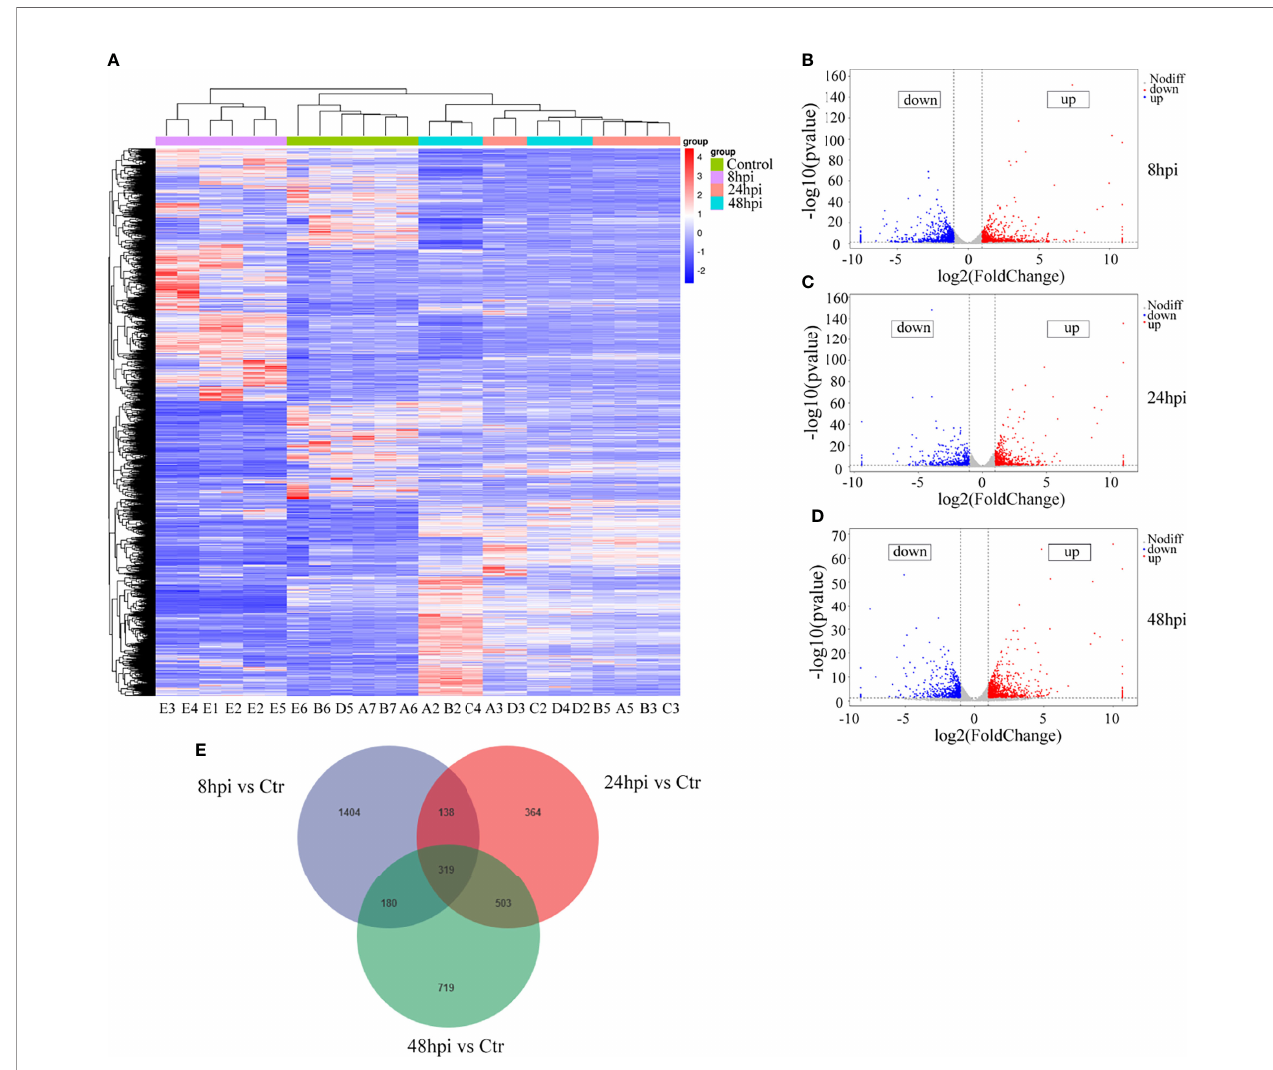
FIGURE 4 | RNA-seq sequencing analysis of H1N1-infected hNEC cells. After 8h, 24h, and 48h of H1N1 virus infection of hNEC cells, the cells were collected for transcriptome sequencing (RNA-seq). (A) Heat map showing all differential gene expression pro fi les of H1N1 virus-infected hNEC cells at 8h, 24h, and 48h compared to control. Each column represents a hNEPCs sample from a different person. (B) Volcano plot showing all up- and down-regulated differential genes in hNEC cells infected with H1N1 virus at 8h compared to control. (C) Volcano plot showing all up- and down-regulated differential genes in hNEC cells infected with H1N1 virus at 24h compared to control. (D) Volcano plot showing all up- and down-regulated differential genes in hNEC cells infected with H1N1 virus at 48h compared to control. Each dot represents a gene, red dots represent up-regulated, blue dots represent down-regulated and grey dots represent no difference. (E) Venn diagrams showed that H1N1 virus infected hNEC cells for 8h, 24h, and 48h compared with the control group, and there were 319 overlaps in all differential